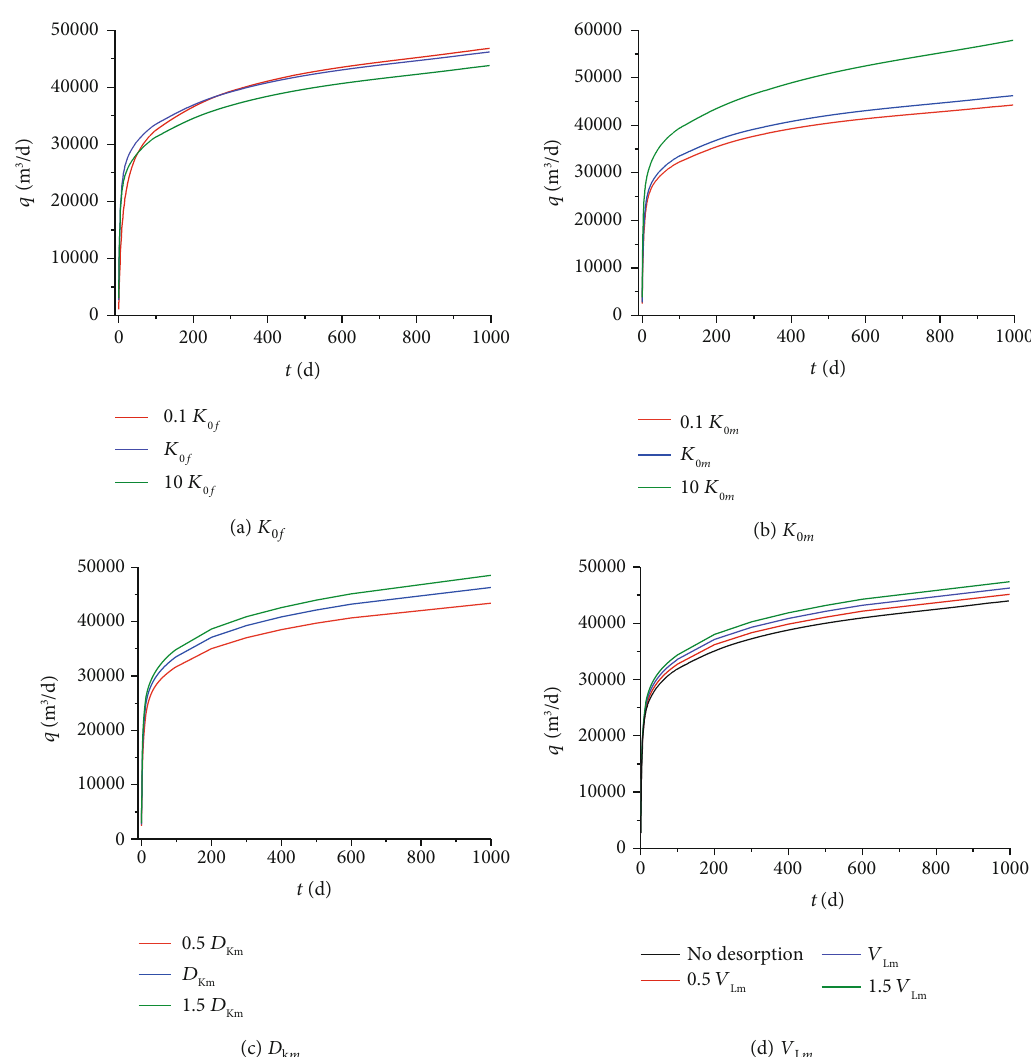
Figure 12: Change in cumulative production with di ff erent parameters for the lattice-like